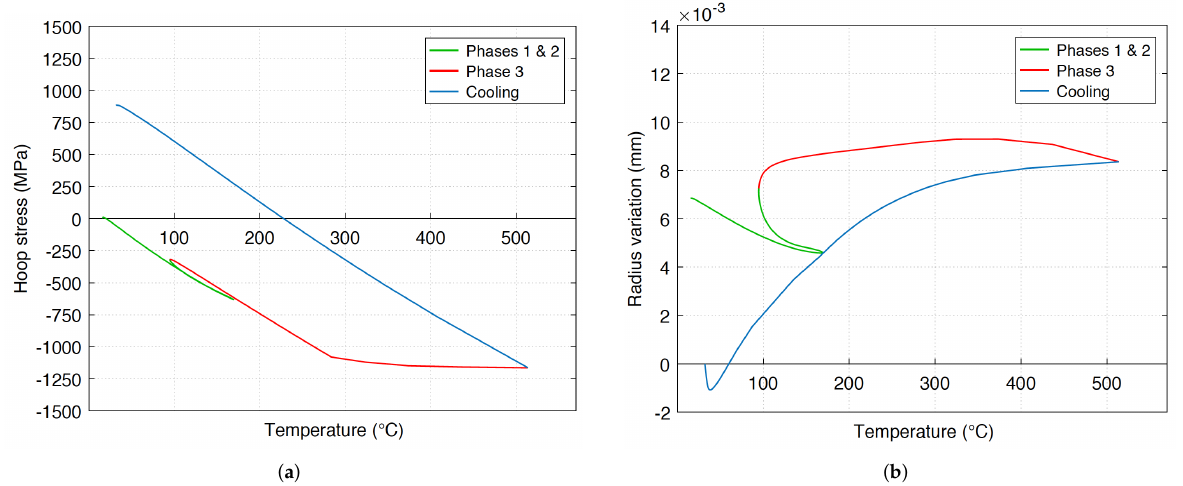
Figure 21. Mechanical history of the hole surface simulated during the dry drilling at mid-depth: ( a ) hoop stress evolution; and ( b ) radius variation in reference to the final